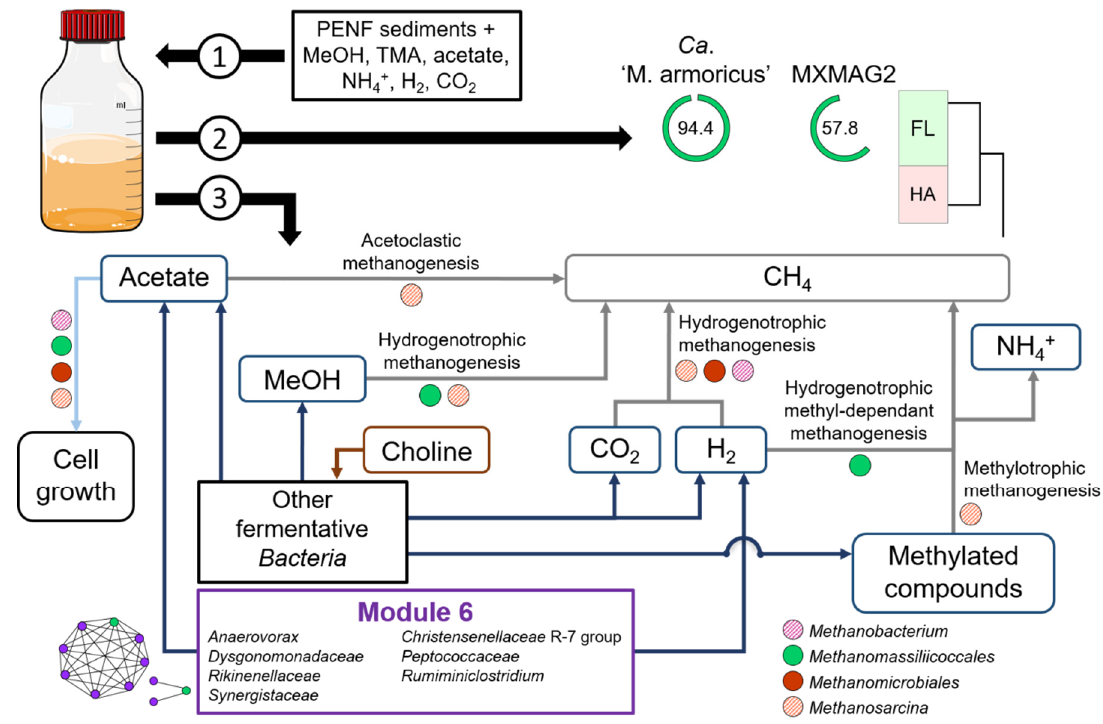
Figure 7. Schematic diagram representing the substrates amended to the original slurry in the culture-based incubation experiment PENF (1) which led to the reconstruction of two Methanomassiliicoccales MAGs ( Ca. ‘M. armoricus MXMAG1 ′ and MXMAG2) affiliated to the ‘free-living’ clade (2). Tentative reconstruction of the microbial metabolic interactions and substrate functions in this culture-based incubation experiment (3). The purple frame represents the module 6 of the co-occurrence network analysis, composed of reported fermentative Bacteria which maintained strong non-random co-occurrences with the dominant Methanomassiliicoccales OTUs sequences; FL: ‘Free-living’ clade; HA: ‘Host-associated’ clade; numbers in green rings indicate the completeness of the two Methanomassiliicoccales MAGs; dark blue arrows indicate fermentative products; grey arrows indicate the methanogenesis pathways probably occurring in this slurry; brown arrow indicates a fermentative substrate found in the enrichment slurry; light blue arrow indicates that acetate is potentially consume for methanogens cell growth. The colored circles indicate the dominant methanogenic taxa during the enrichment process and their known metabolic properties. The hatched color indicates that this property is present in only a part of the taxa of the lineage.